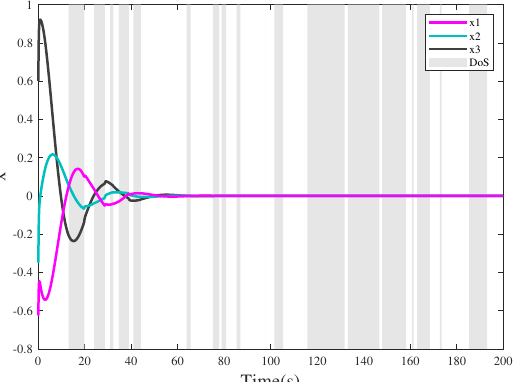
Figure 11. The stable state trajectories under aperiodic DoS attacks.